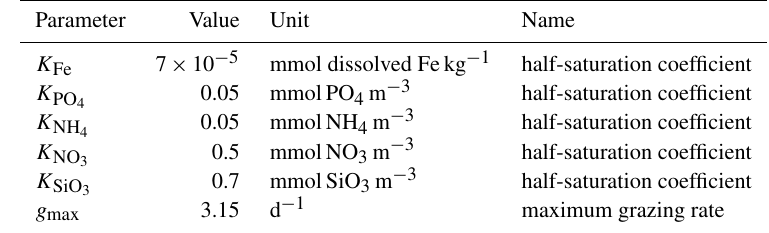
Table A6. Parameter values used in MARBL to compute the production and loss of large phytoplankton.